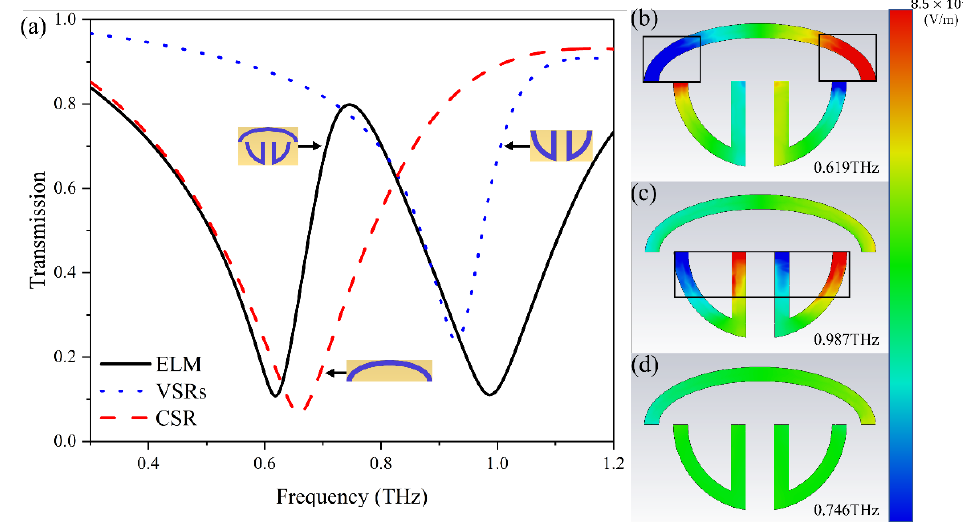
Figure 2. ( a ) Transmission spectra of individual CSRs, individual VSRs, and the entire ELM. ( b – d ) Electric field distribution of the ELM in the z-direction at frequencies of 0.619 THz, 0.987 THz, and 0.746 THz, respectively.